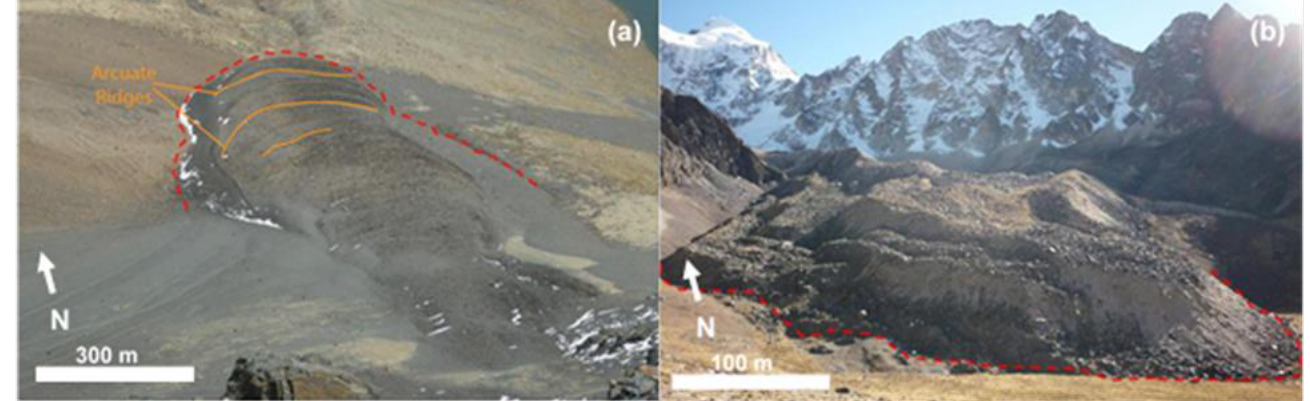
Figure 3. Terrestrial rock glacier Martian analogs. Bolivian rock glaciers; ( a ) well-defined arcuate ridges and depressions extent marked orange at Pico Austria, Tuni Condoriri region; ( b ) rock glacier front analog at Huayna Potosi, rock glacier with an over-steepened front slope ~43°. Photo credit: S Rangecroft, July 2011, August 2012.